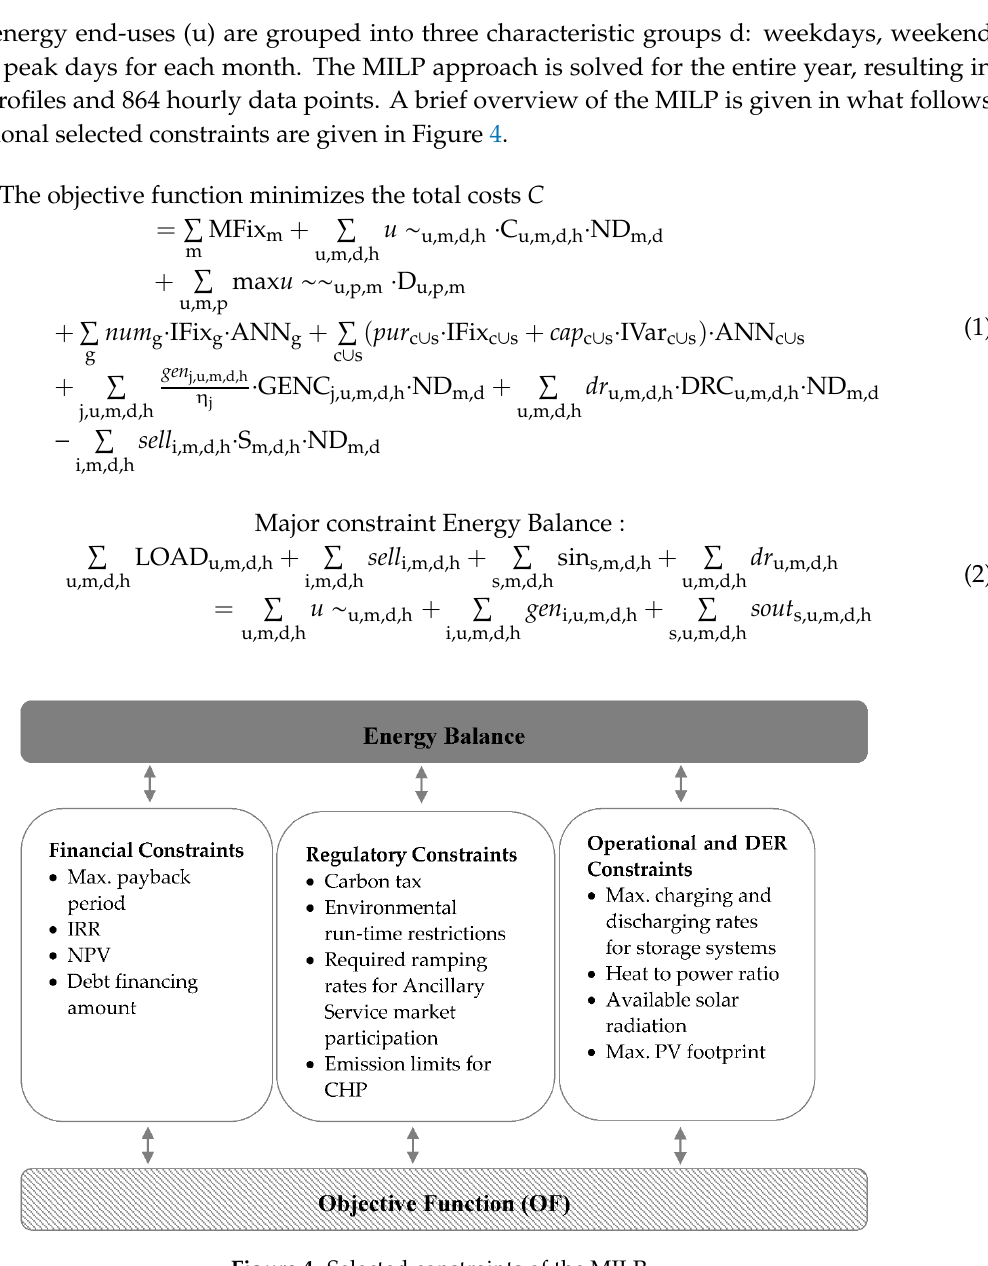
Figure 4. Selected constraints of the MILP.